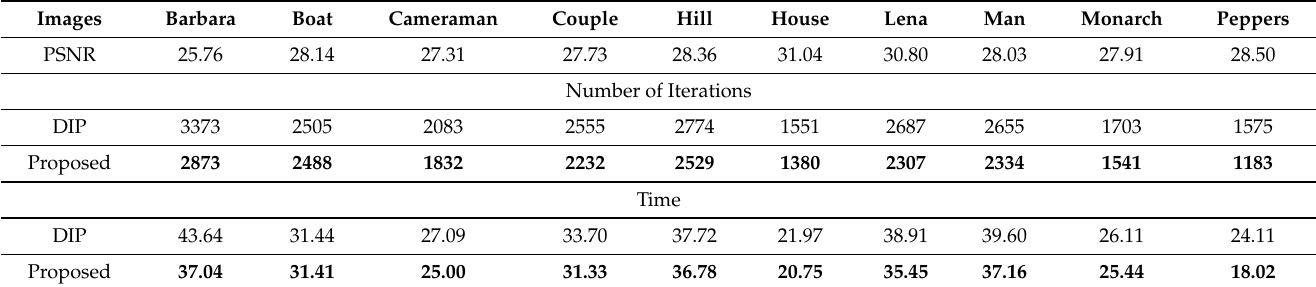
Table 5. Number of iterations and time(s) of two methods on 10 commonly used images with σ = 30.